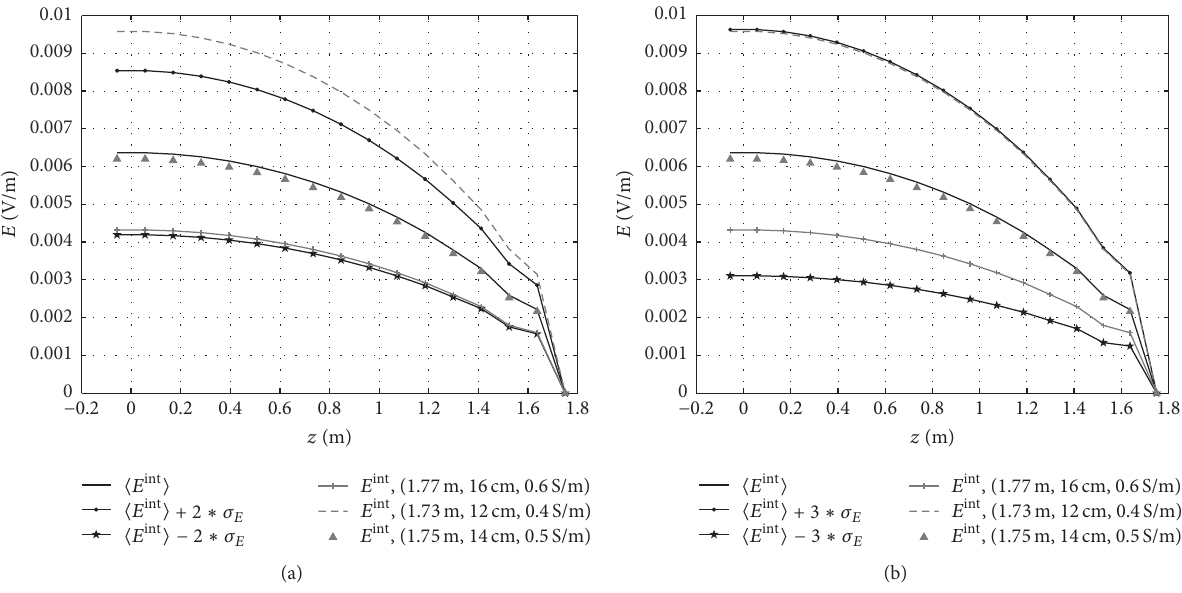
Figure 6: Induced electric field in the human body with three RVs—length, radius, and conductivity (𝐿,𝑎, 𝜎) : ⟨𝐸 int ⟩ is stochastic expected value, 𝜎 𝐸 is standard deviation, and 𝐸 int is the value obtained from numerical deterministic model. (a) Confidence interval of 95.45% is given as ±2𝜎 𝐸 margins around mean. (b) Confidence interval of 99.7% is given as ±3𝜎 𝐸 margins around mean.